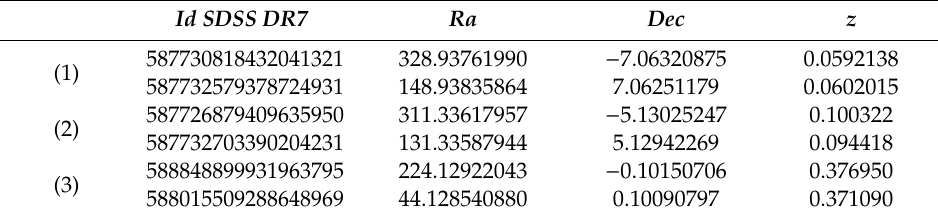
Table 1. Pairs of opposite galaxies for the e ff ect of cosmic mirror [36]. Id SDSS DR7—objID